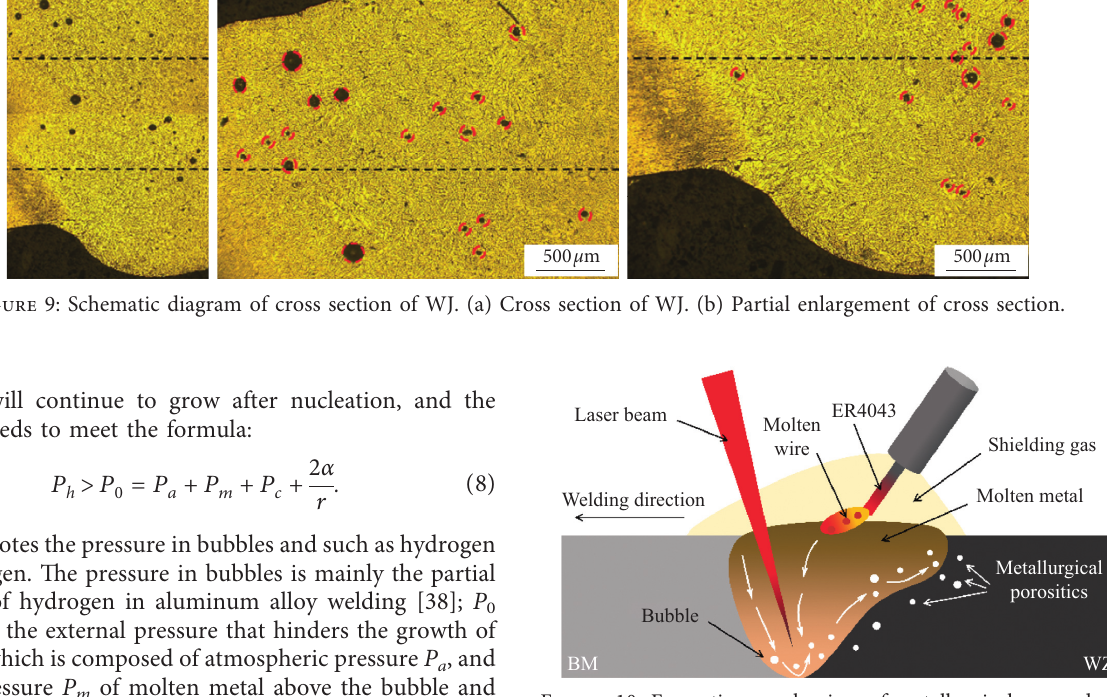
Figure 10: Formation mechanism of metallurgical pores during laser-MIG hybrid welding